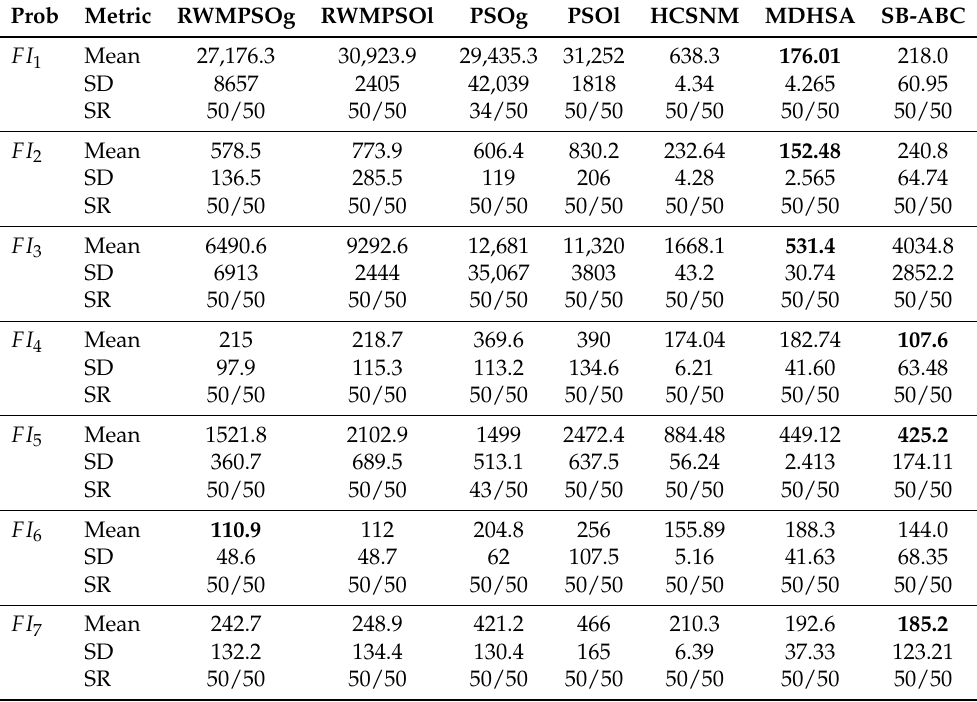
Table 3. Comparison results of the RWMPSOg, RWMPSOl, PSOg, PSOl, MDHSA, HCSNM and SB-ABC for the FI 1 – FI 7 integer programming problems.